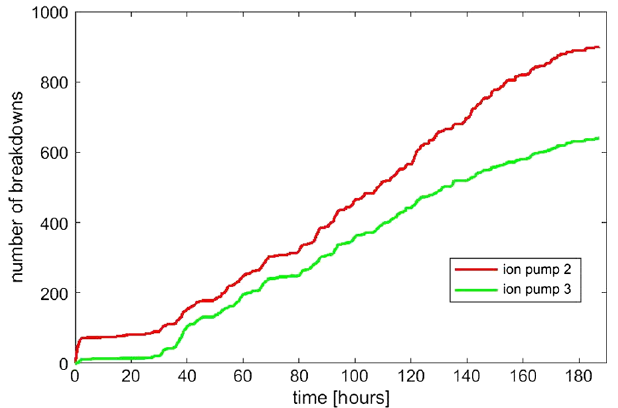
FIG. 19. Number of cumulated breakdowns calculated by peaks on a vacuum measured by ion pumps 2 and